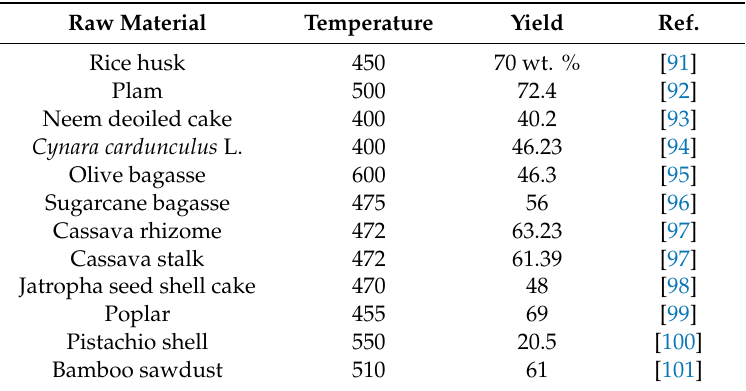
Table 2. Suitable temperatures for di ff erent